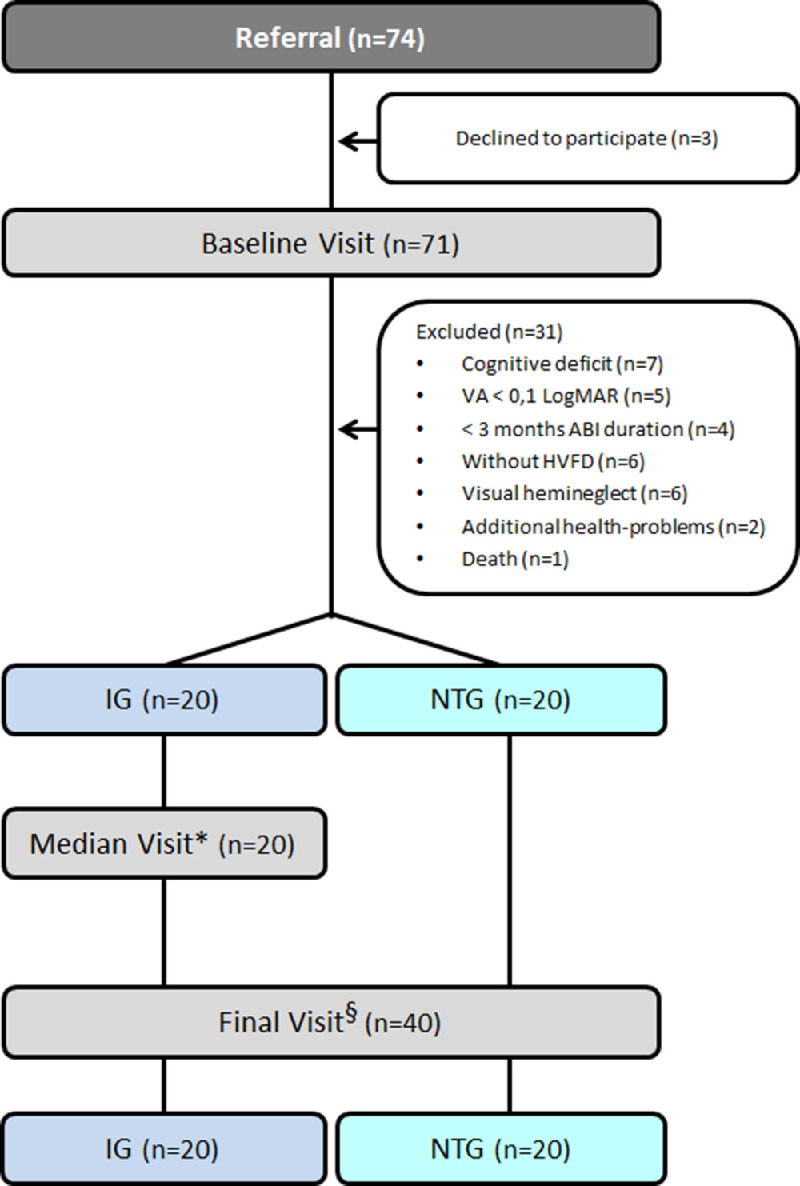
The flow chart of patient recruitment and follow-up assessment visits. *Performed by IG six weeks after the baseline visit, which coincided with the third in-office visit included at the training protocol. §Performed by both study groups at 12 weeks after the baseline visit. VA LogMAR, logarithm of the minimum angle of resolution visual acuity.